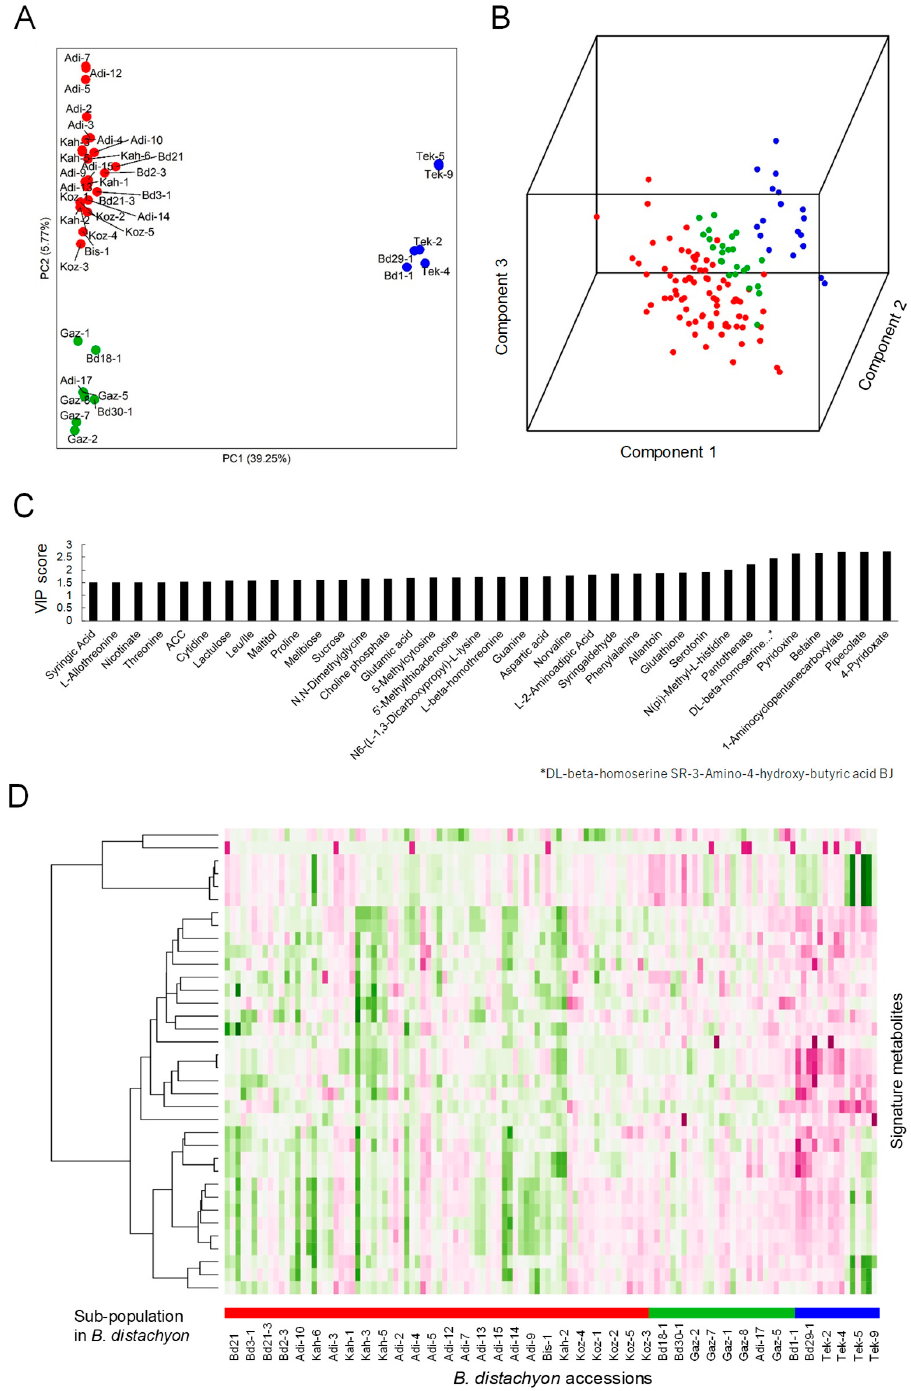
Figure 1. Genotype and metabolotype variation across forty B. distachyon inbred lines. ( A ) PCA plot of the forty natural B. distachyon lines based on the biallelic SNP dataset generated using publicly available GBS and whole-genome sequencing data. ( B ) PLS-DA plot of the forty B. distachyon lines based on accumulation profiles of the 183 metabolites in mature seeds. The colors for individuals are the same as in ( A ). ( C ) The signature metabolites based on the variable importance of projection (VIP) score (>1.5) of PLS-DA analysis. ( D ) Accumulation patterns of the signature metabolites across the forty B. distachyon lines. The heatmap represents hierarchically clustered accumulation patterns of the signature metabolites based on the normalized binary logarithm (log2) values of their quantitative